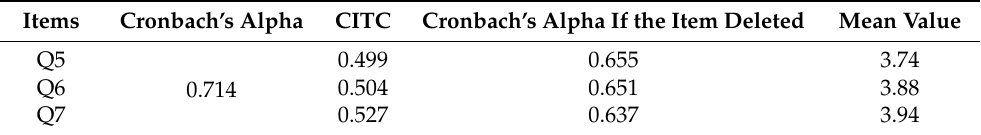
Table 5. The reliability analysis of group closure of construction workers.